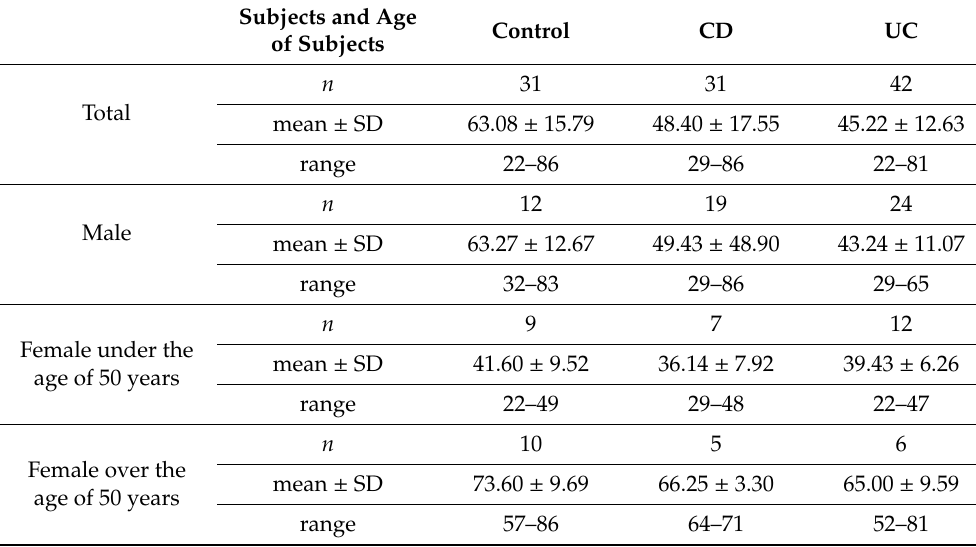
Table 3. Demographic profiles of control subjects and IBD patients enrolled in the